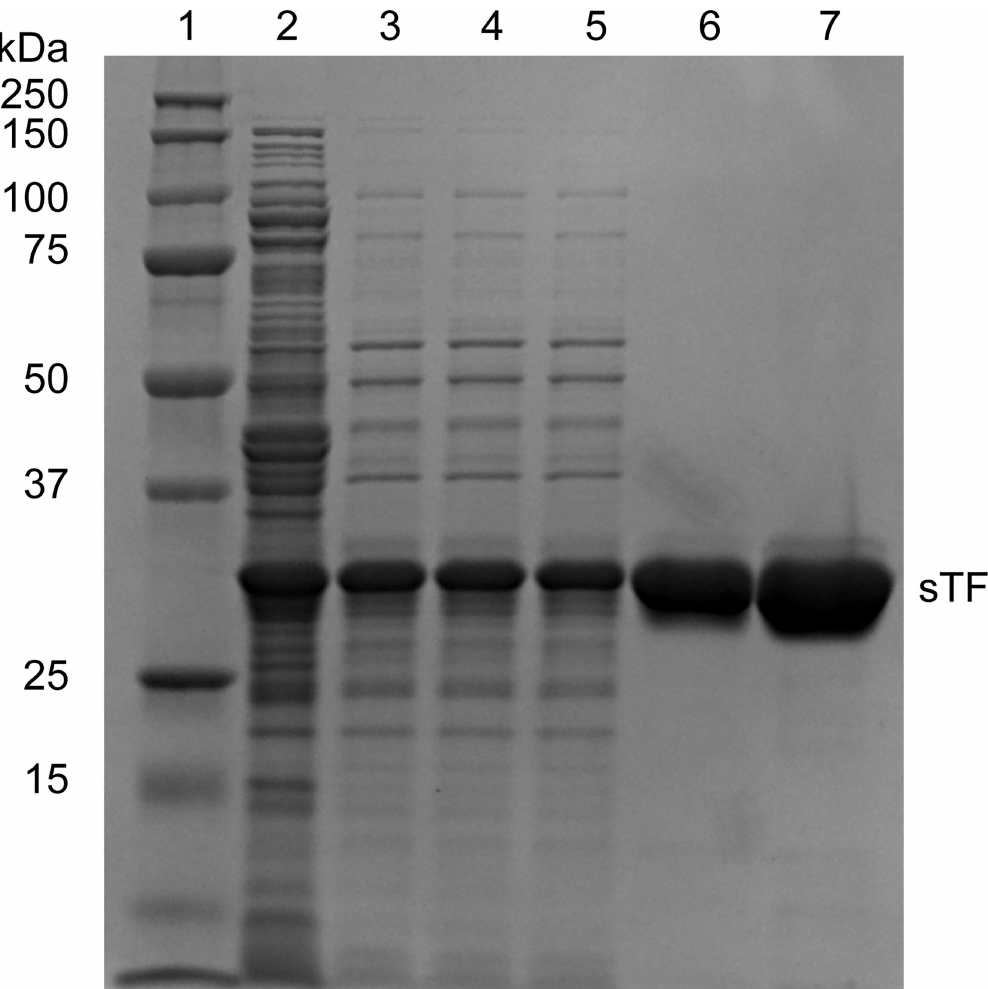
Fig 1. SDS-PAGE analysis of sTF purification. SDS-PAGE 12% acrylamide gel of sTF samples stained with CoomassieBrilliant Blue R-250 showing:Lane 1: Precision Plus Protein TM Dual Color marker (Bio-Rad, Hercules, CA, USA); Lane 2: water and sucrose combinedsupernatant; Lane 3: Q-Sepharose 1 Fast Flow supernatant; Lane 4: Post 0.45 μ m filter; Lane 5: pre-loadon Ni 2+ affinity column; Lane 6: 500 mM imidazoleelution; Lane 7: concentrated